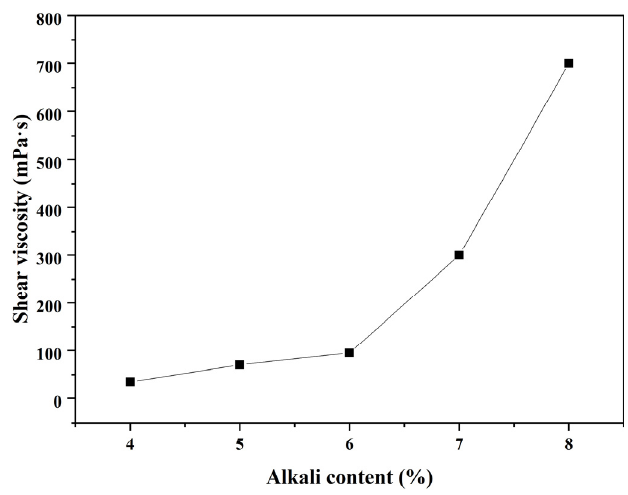
Figure 5. Effect of alkali content on fluidity.